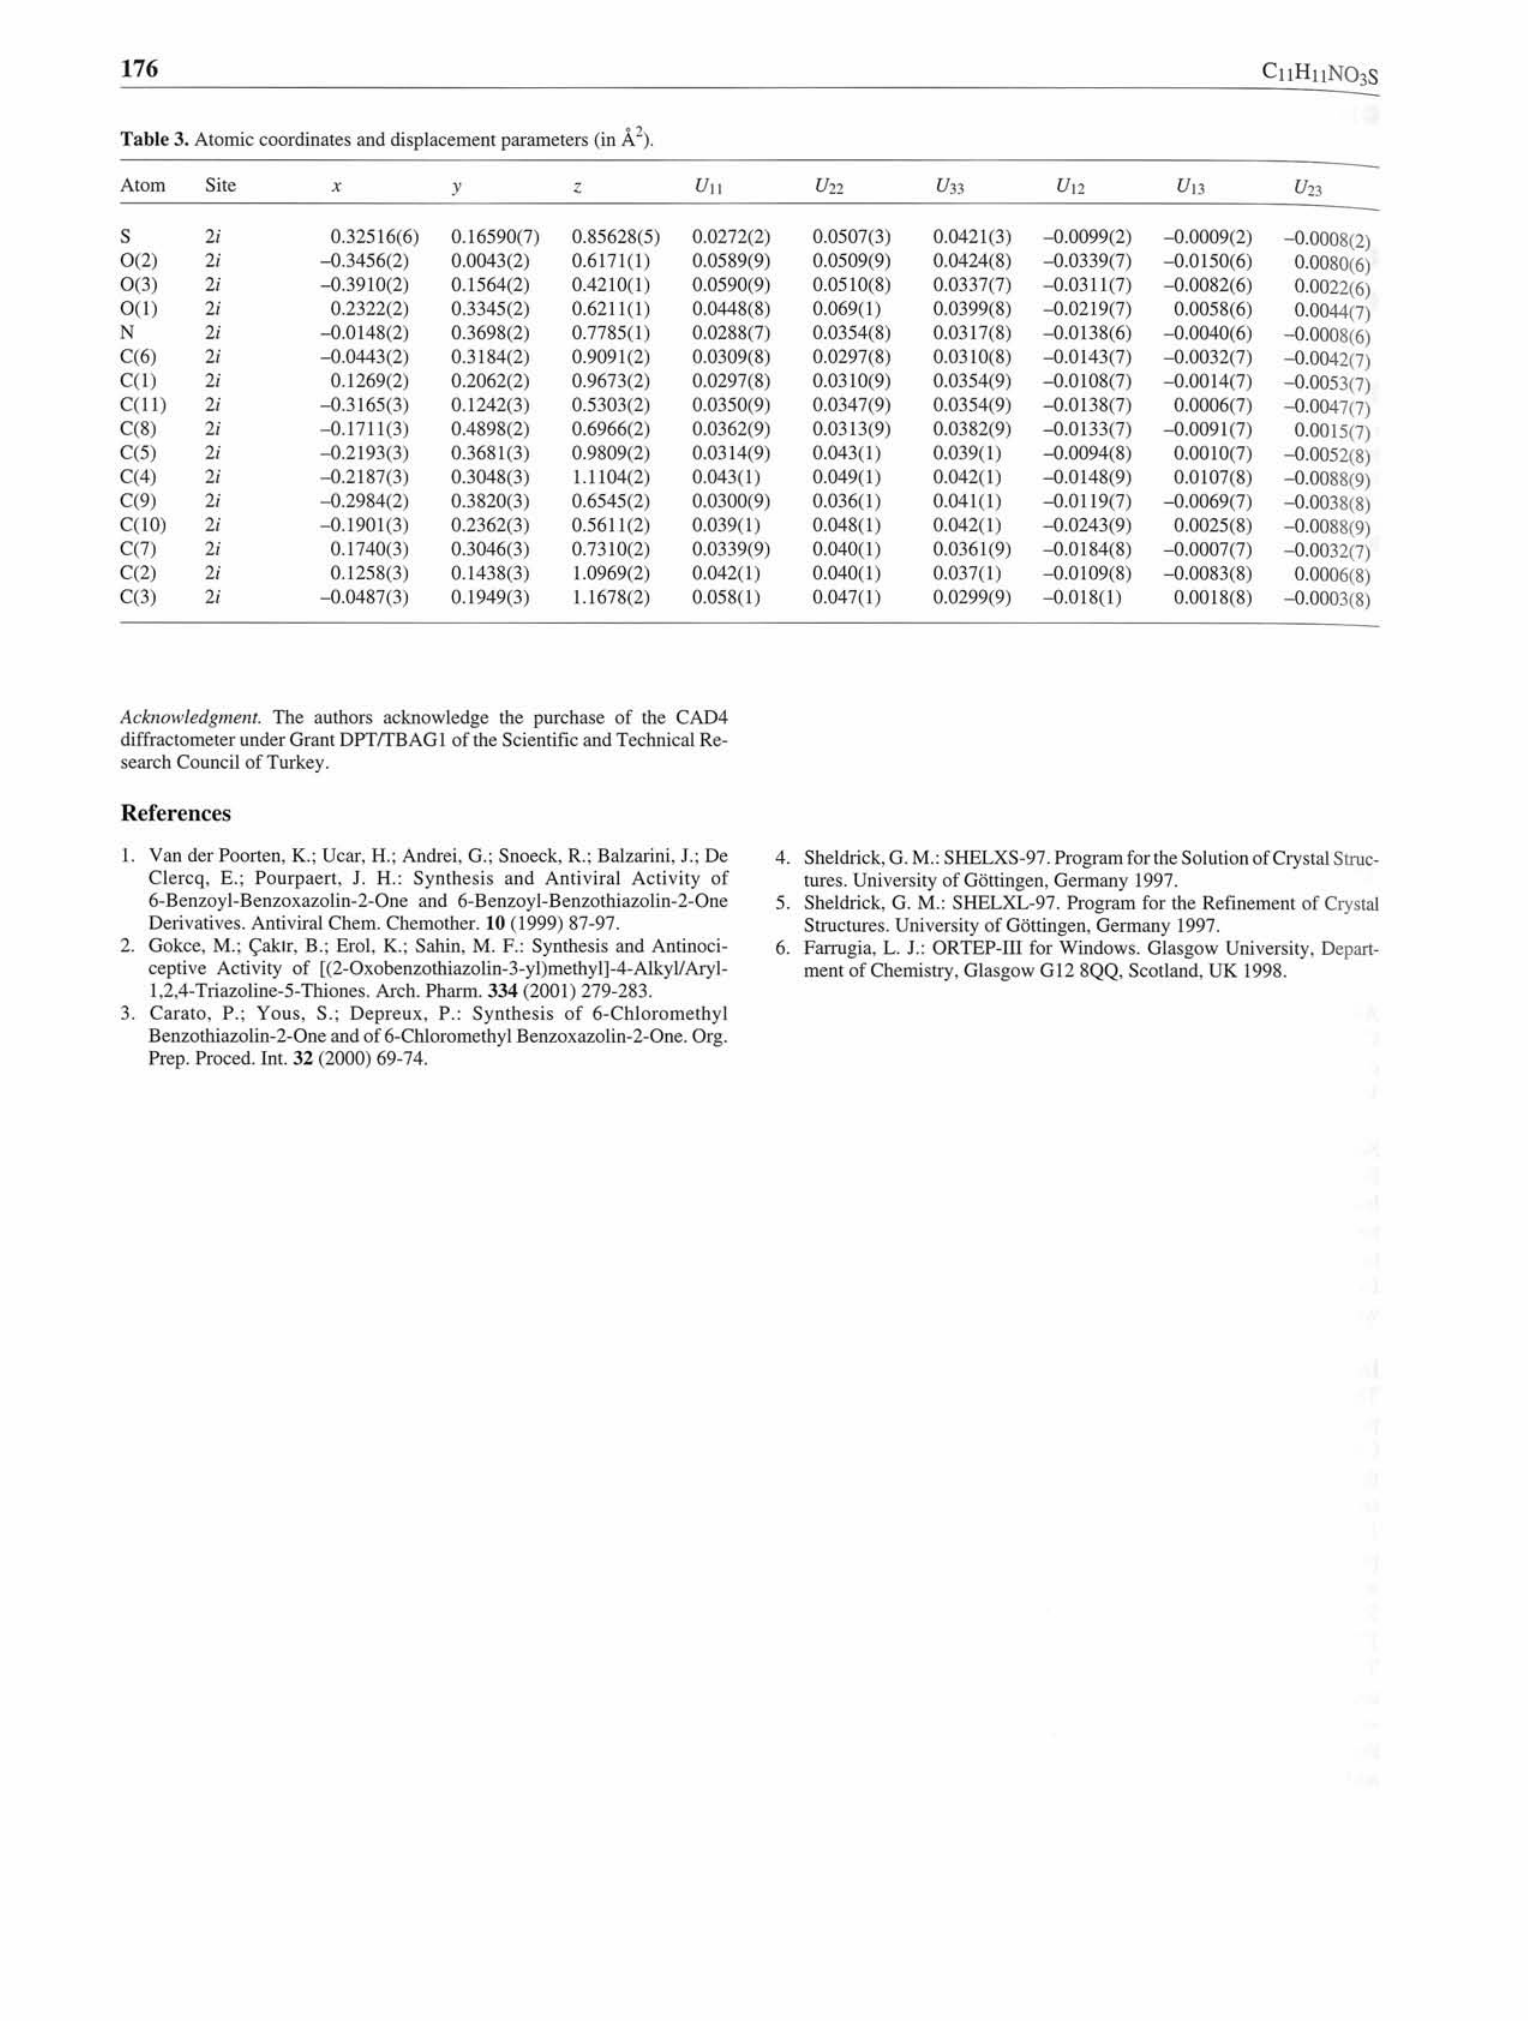
Table 3. Atomic coordinates and displacement parameters (in Â 2